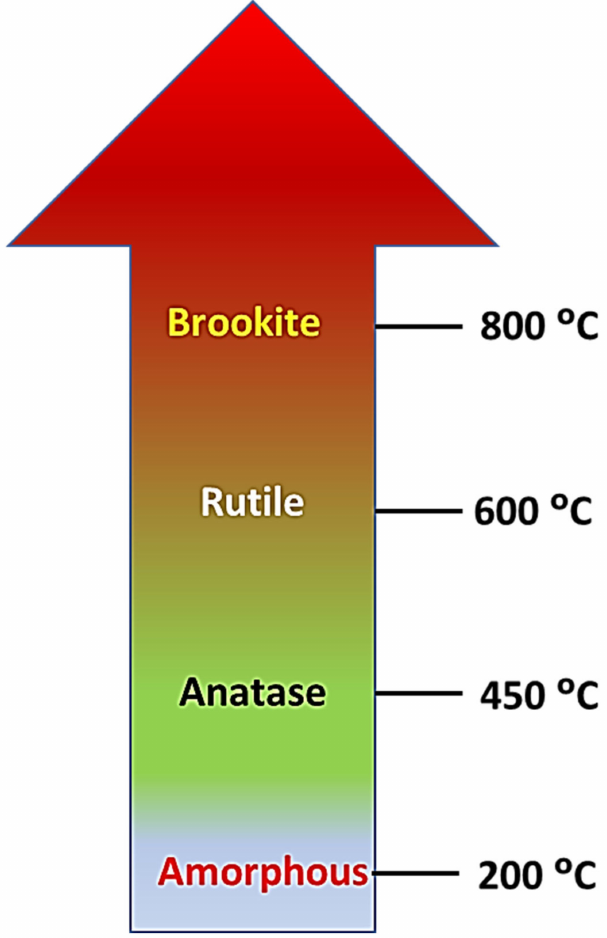
Figure 6. The TiO 2 crystal phase dependency on annealing